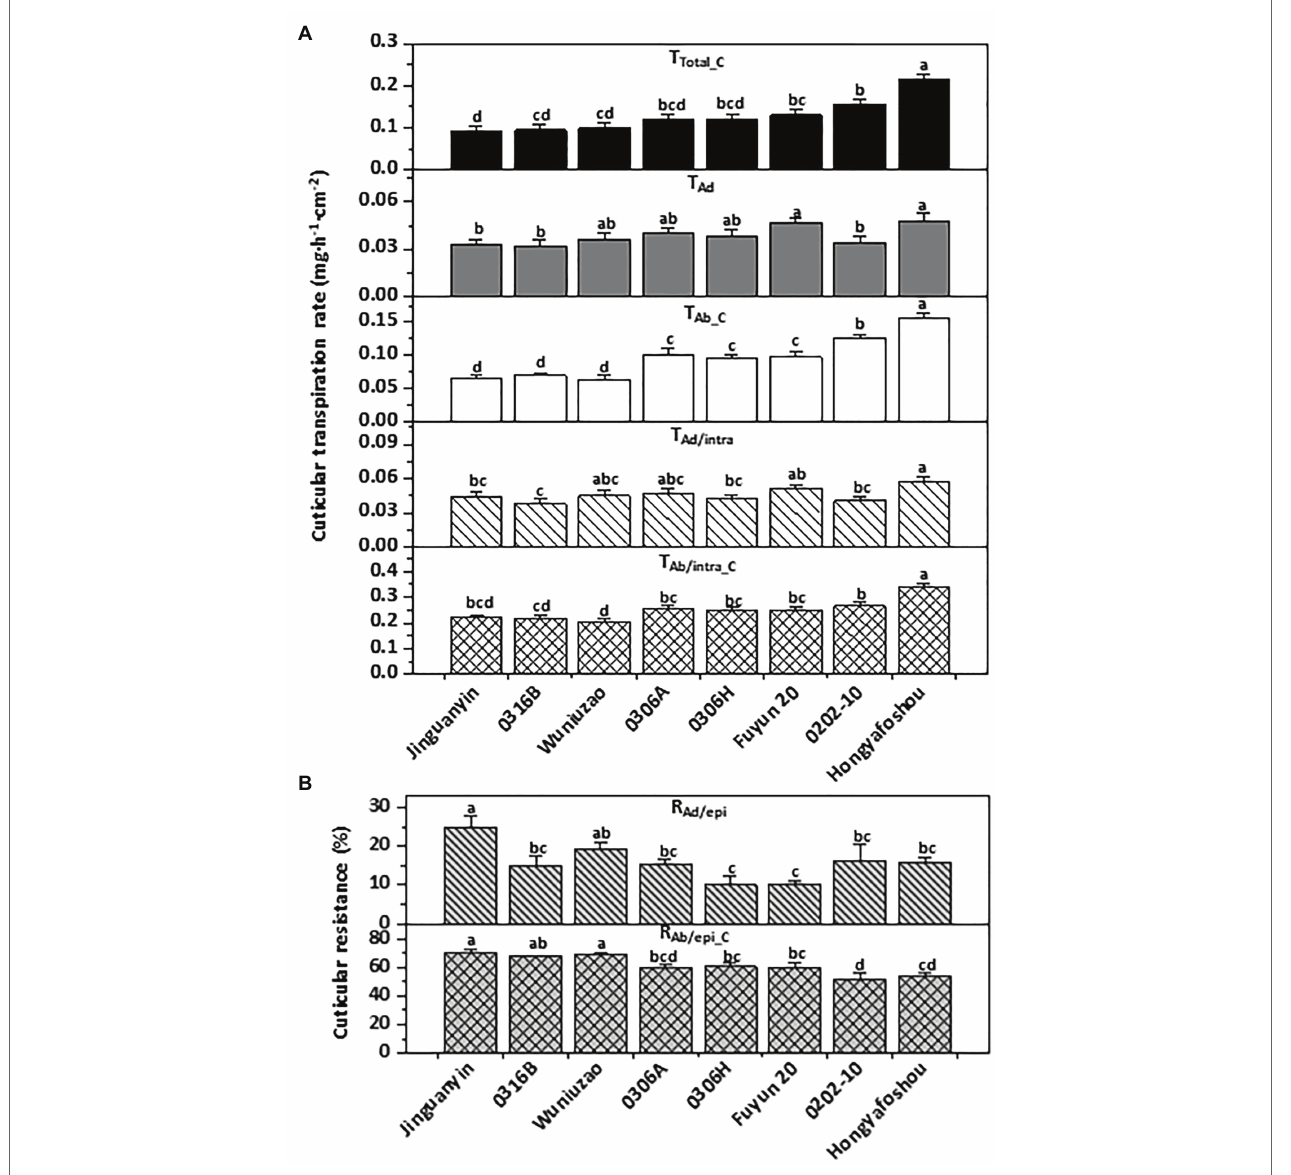
FIGURE 4 | Cuticular transpiration rate (A) and epicuticular resistance (B) of the eight tea germplasms. Different lowercase letters represent the statistical significance ( p < 0.05). T Total_C : the total cuticular transpiration rate; T Ad : the adaxial cuticular transpiration rate; T Ab_C : the abaxial cuticular transpiration rate; T Ad/intra : the adaxial intracuticular transpiration rate; T Ab/intra_C : the abaxial intracuticular transpiration rate; R Ad/epi : the adaxial epicuticular resistance; R Ab/epi_C : the abaxial epicuticular